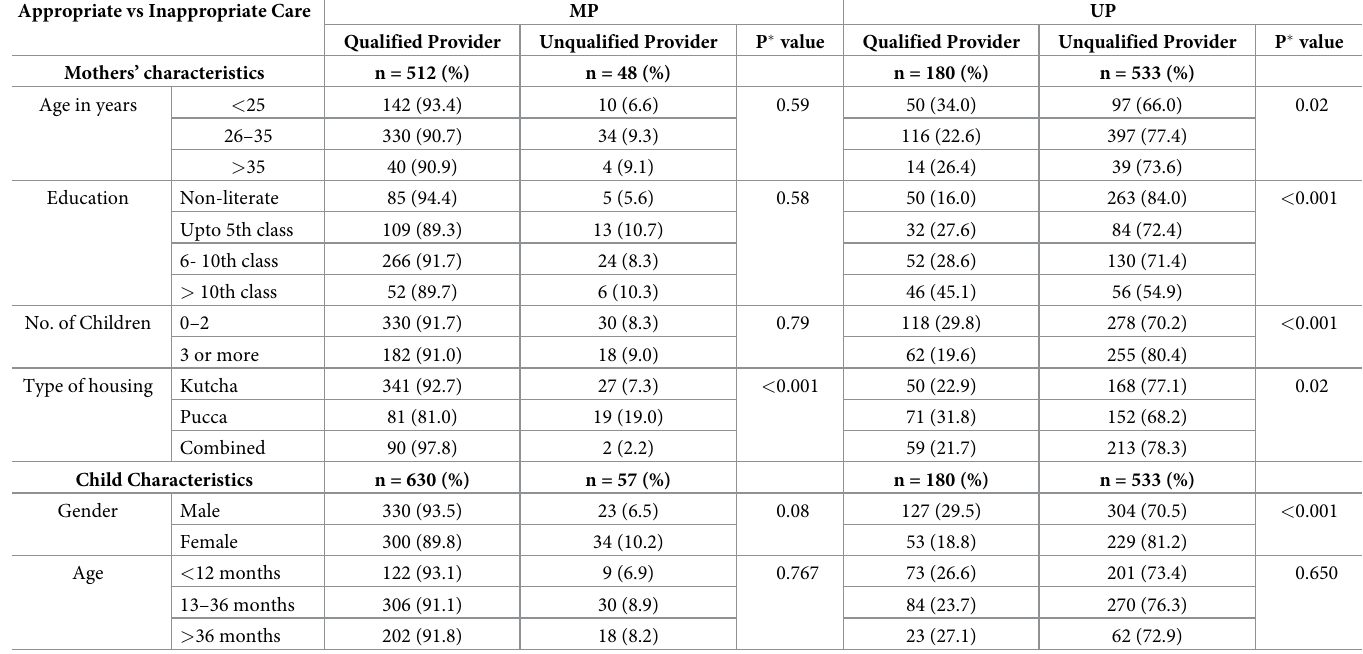
Table 8. Association of socio-demographic characteristics to appropriate care